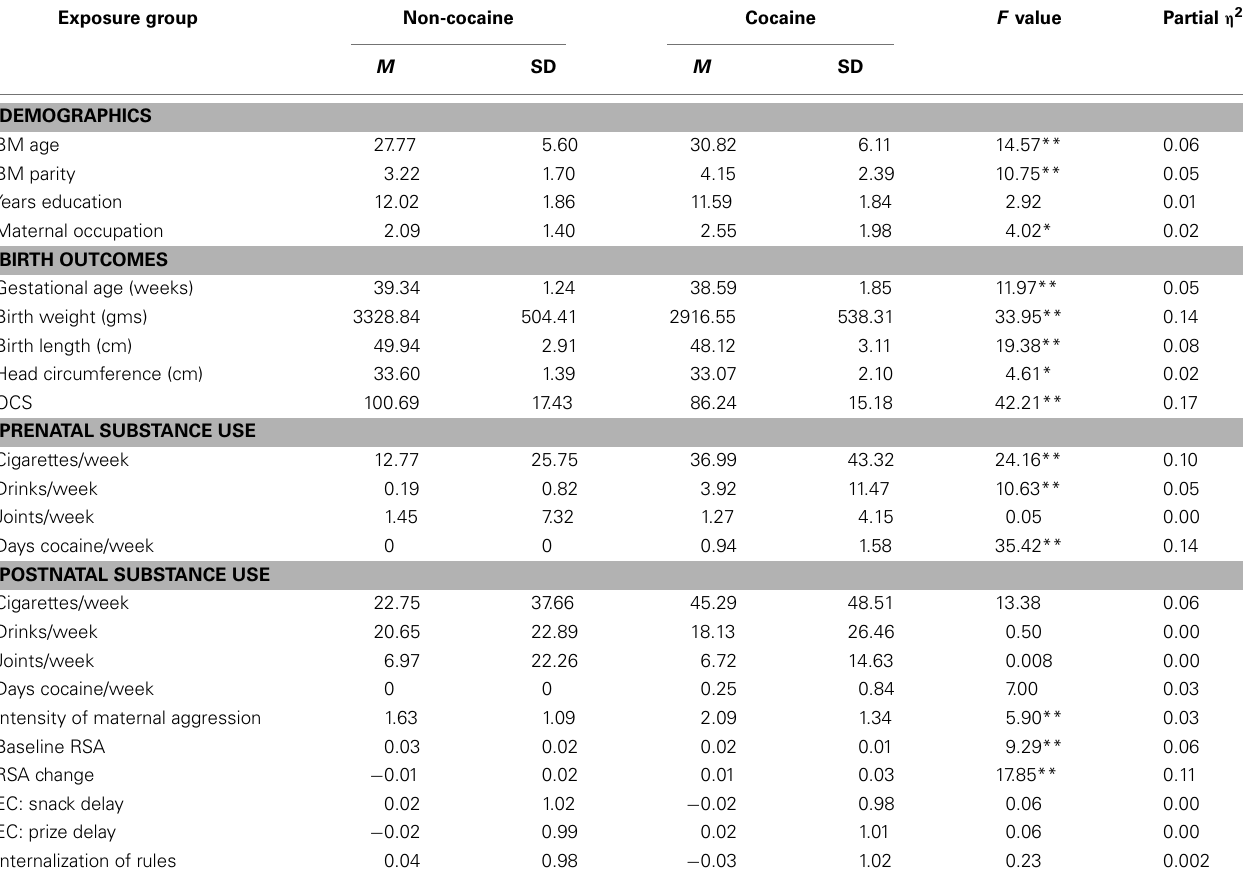
Table 1 | Group differences in demographic variables, birth outcomes, and substance use. Exposure group